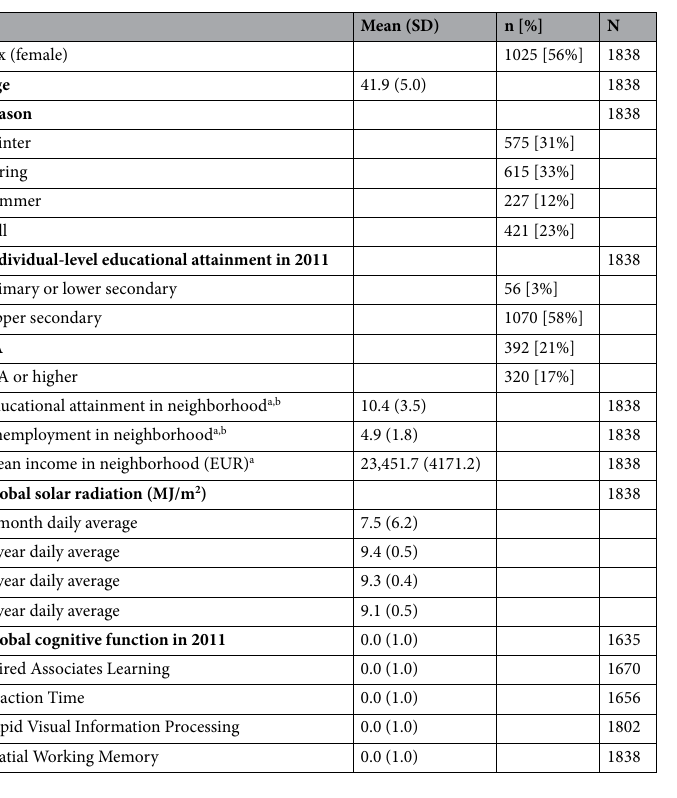
Table 1. Characteristics of 1,838 participants from the Cardiovascular Risk in Young Finns study. a Values are 1-year daily averages based on participants’ residential information. b Educational attainment and unemployment in neighborhood were calculated based on the proportion of participants with a college degree and proportion of participants unemployed in neighborhood (zip code